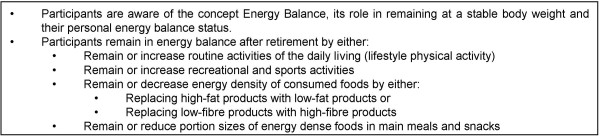
Programme objectives of the intervention programme.